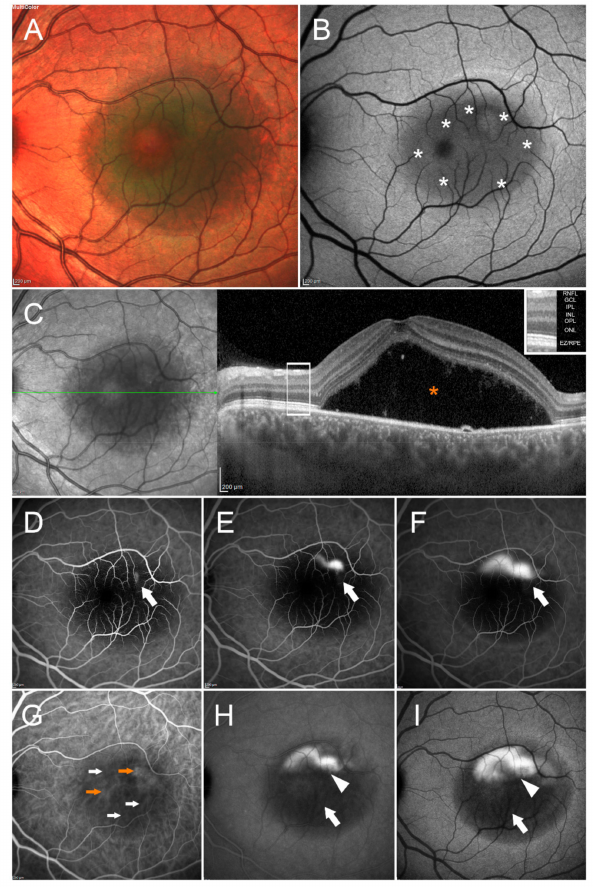
Figure 1. Multimodal imaging in central serous chorioretinopathy. Multicolor ( A ) image shows a mainly green round alteration involving the entire macular region. The green color may be interpreted as fluid accumulation. Blue autofluorescence (BAF) ( B ) image discloses the presence of a round hypoautofluorescent alteration (white asterisks), secondary to the masking effect made by the subretinal fluid. The presence of this latter is confirmed by structural optical coherence tomography (OCT) ( C ), showing a marked dome-shaped subretinal fluid accumulation (orange asterisk). The OCT layers legend is provided in the upper-right part of the images. FA examination discloses just a macular hypofluorescent signal on early phase (white arrow) ( D ), with the onset and enlargement of a hyperfluorescent spot in the superior macular region, detected on intermediate and late phases (white arrows) (( E , F ), respectively). ICGA highlights choroidal vasculature hypercyanescent (orange arrow) and hypocyanescent (white arrow) alterations in the early phase ( G ); intermediate ( H ) and late ( I ) phases disclose a mainly hypocyanescent round signal (white arrow), with the presence of hypercyanescent superior focal leakage point (white arrowhead). The following abbreviations are used: retinal nerve fiber layer (RNFL), ganglion cell layer (GCL), inner plexiform layer (IPL), inner nuclear layer (INL), outer plexiform layer (OPL), outer nuclear layer (ONL), ellipsoid zone/retinal pigment epithelium complex